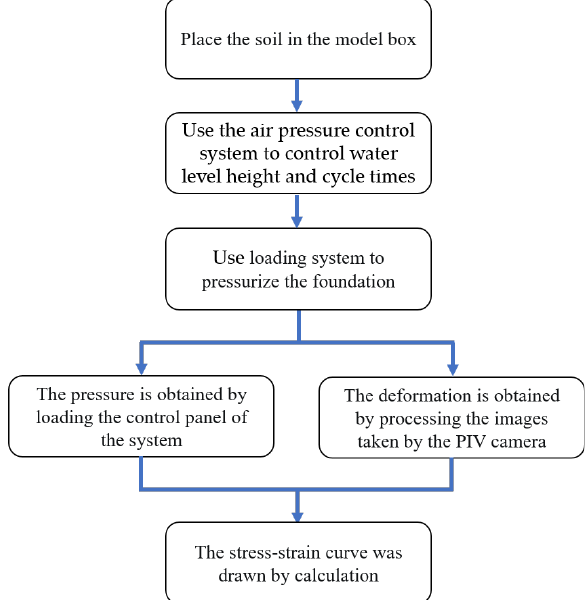
Figure 3. The flowchart of the experiment.